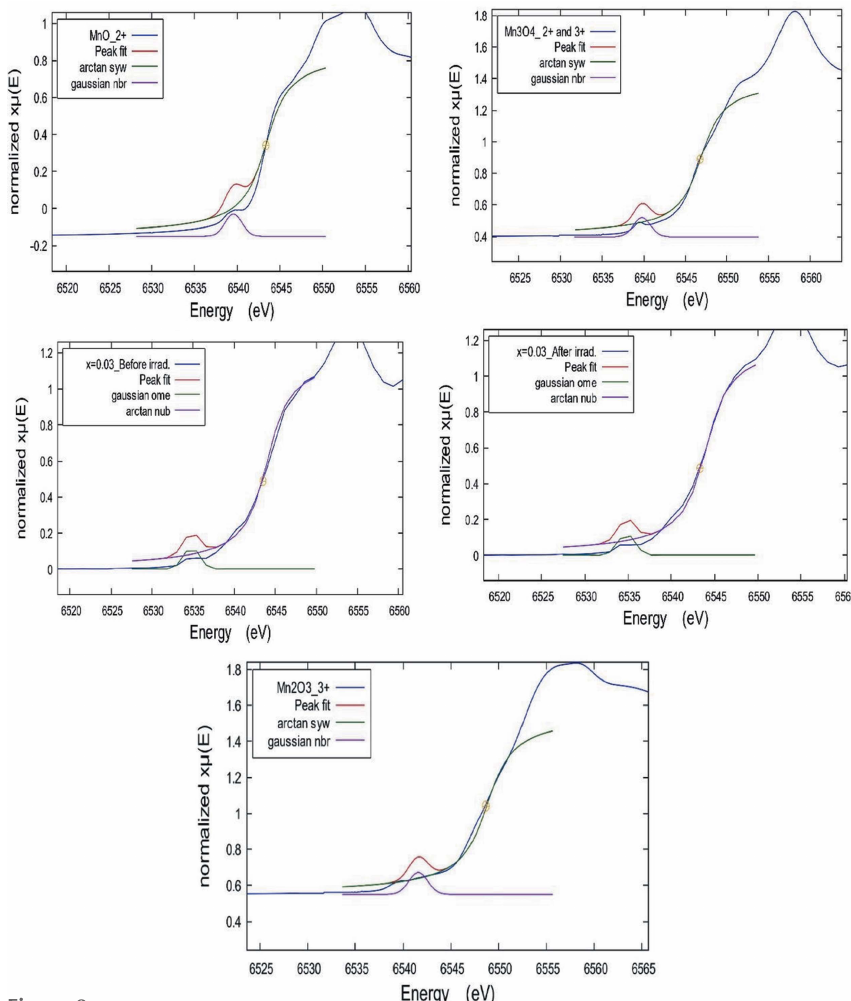
Figure 8 Pre-peak fit of the pristine and irradiated example sample at x = 0.03, along with those of Mn reference standards.